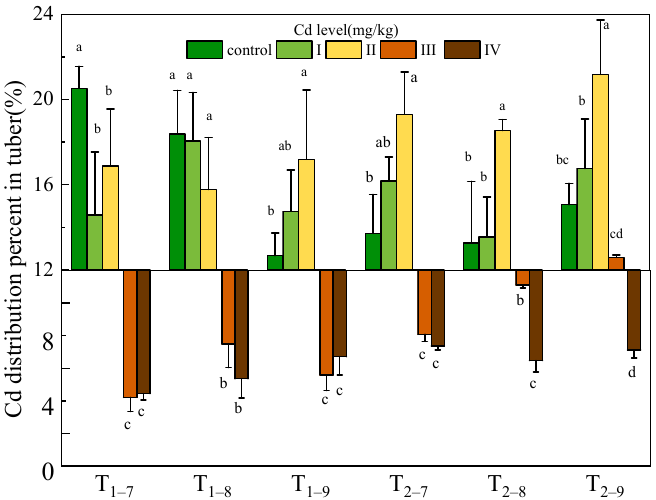
Figure 4. Cd distribution percent in tuber of B. striata plants under Cd treatment control, I, II, III and IV. T i–j means Bletilla striata harvested at a certain point (i = 1,2, represents the year after transplanting; j = 7,8,9, represents the month for sampling). Error bars indicate standard deviation calculated for three replicates. Significant effects of each treatment on values for distribution percent are denoted by different lowercase letters (one-way ANOVA, p < 0.05).